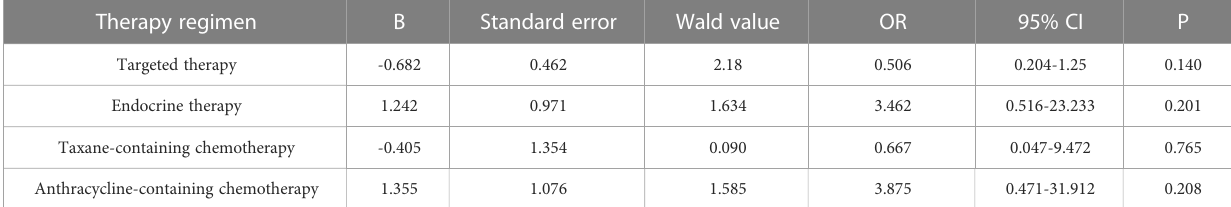
TABLE 5 Logistic multivariate analysis results of treatment regimens on changes in PR expression. Therapy regimen